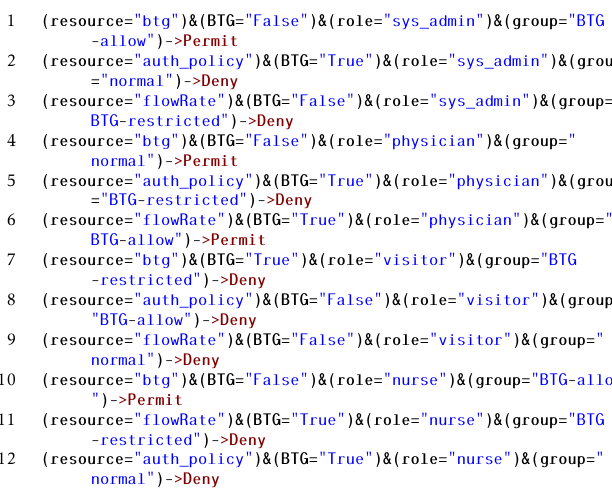
Figure 10. Policy inconsistency shown with a counterexample, reformatted for readability